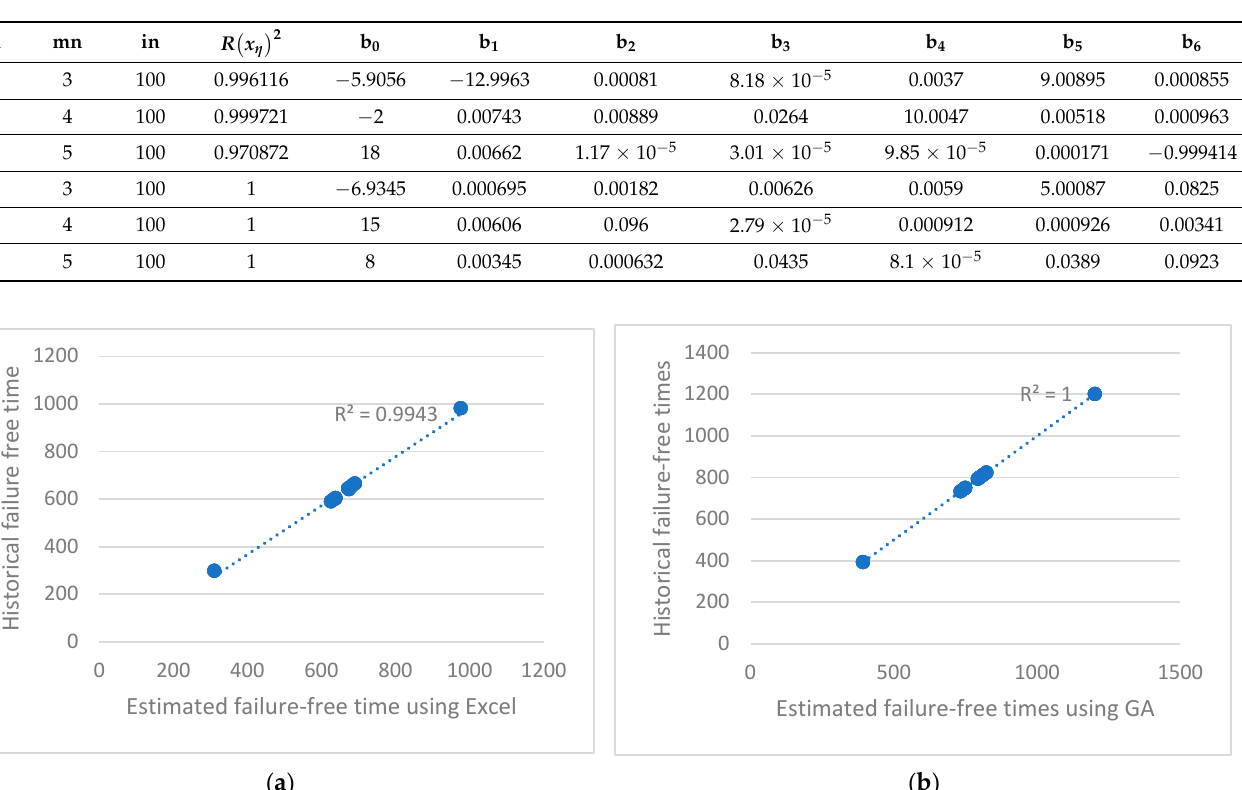
Table 5. Multiple determination coefficients obtained for regression coefficients (b 0 , b 1 , . . . , b 6 ) in the computer simulation described by {chn = 100, mn, in = 100}.